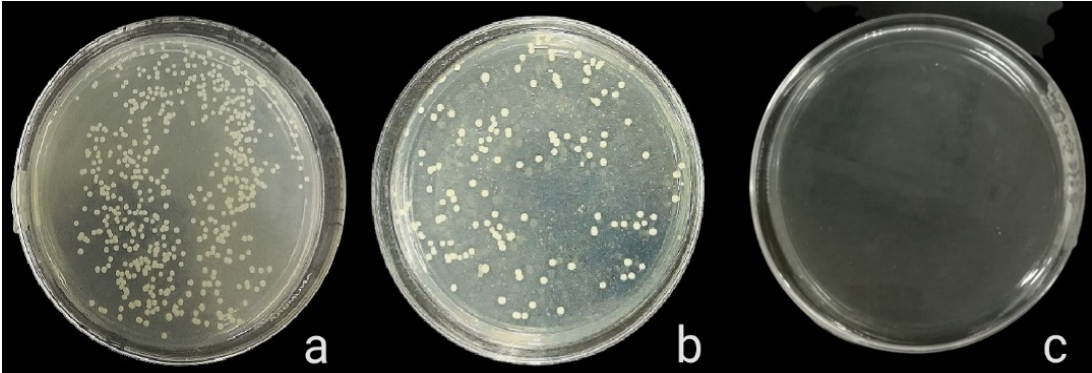
Figure 6. S. mutans growth of unmodified composite discs ( a ), composite discs with 1% AgNPs ( b ), and composite discs with 1% CIP-AgNPs ( c ).